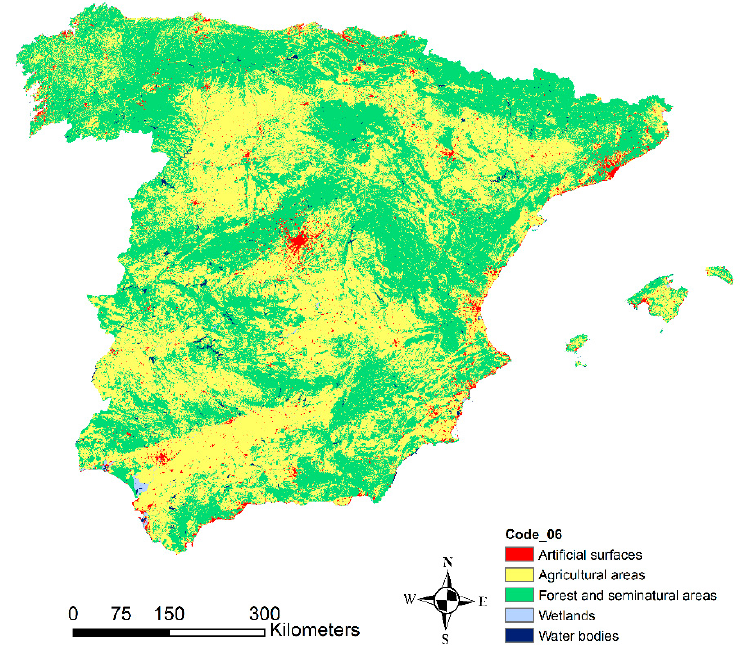
Figure 2. Map of Co-Ordination of Information on the Environment (CORINE) Land Cover (CLC) 2006 classes at level 1 of disaggregation from our study area.